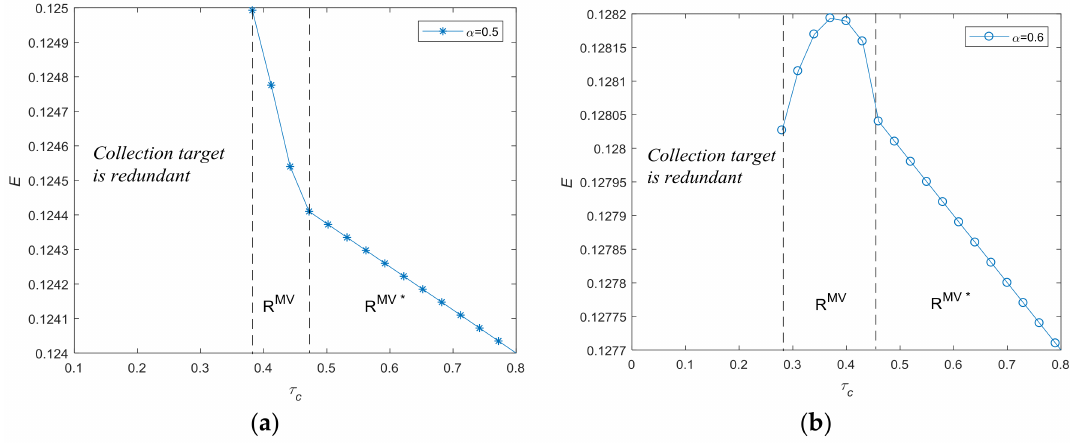
Figure 6. Environmental impact with respect to τ c and α . ( a ) when α = 0.5; ( b ) when α =